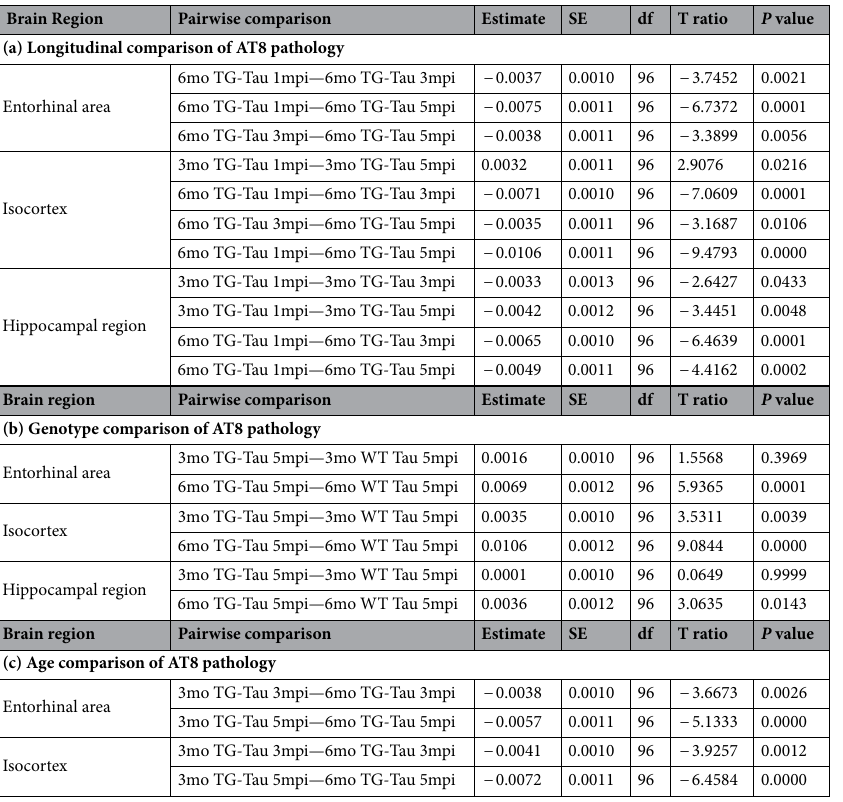
Table 1. Table containing the pairwise comparisons of the amount of quantified AT8-positive tau pathology. Pairwise comparisons between (a) Between timepoints in the same genotype-treatment group, (b) Between genotypes, and (c) Between different age groups. 3mo and 6mo refer to 3- or 6-months old animals. (m.p.i. refers to months post injection). TG refers to APP.PS1 animals, WT refers to wild-type. Tau refers to tau- seeded mice, Buffer refers to phosphate-buffered saline injected mice. SE refers to standard error. Df refers to degrees of freedom. Estimate refers to the estimated difference in value between pairwise comparisons. mo refers to months-old at